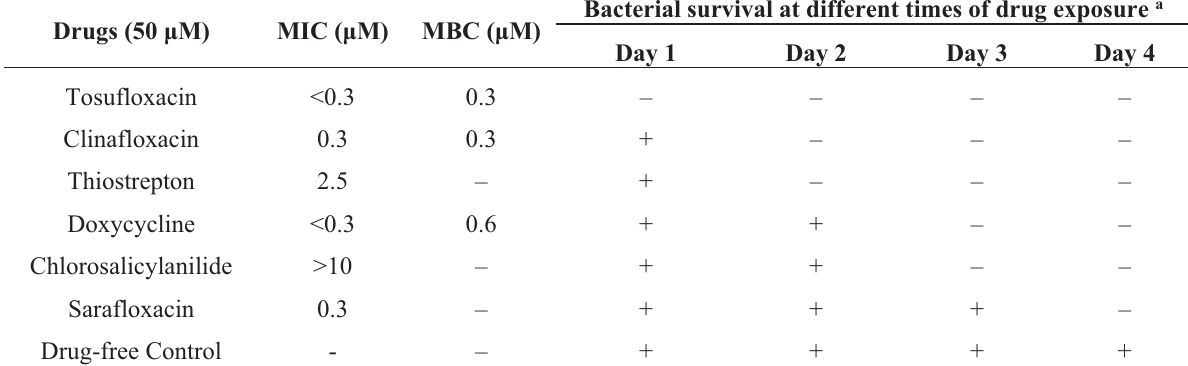
Table 1. Activity of six drug candidates (50 μM) selected from the clinical drug library against stationary-phase S. aureus persisters.